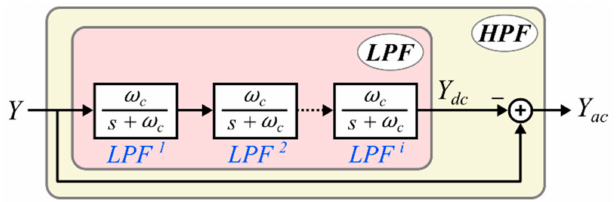
Figure 10. Proposed HPF block diagram.